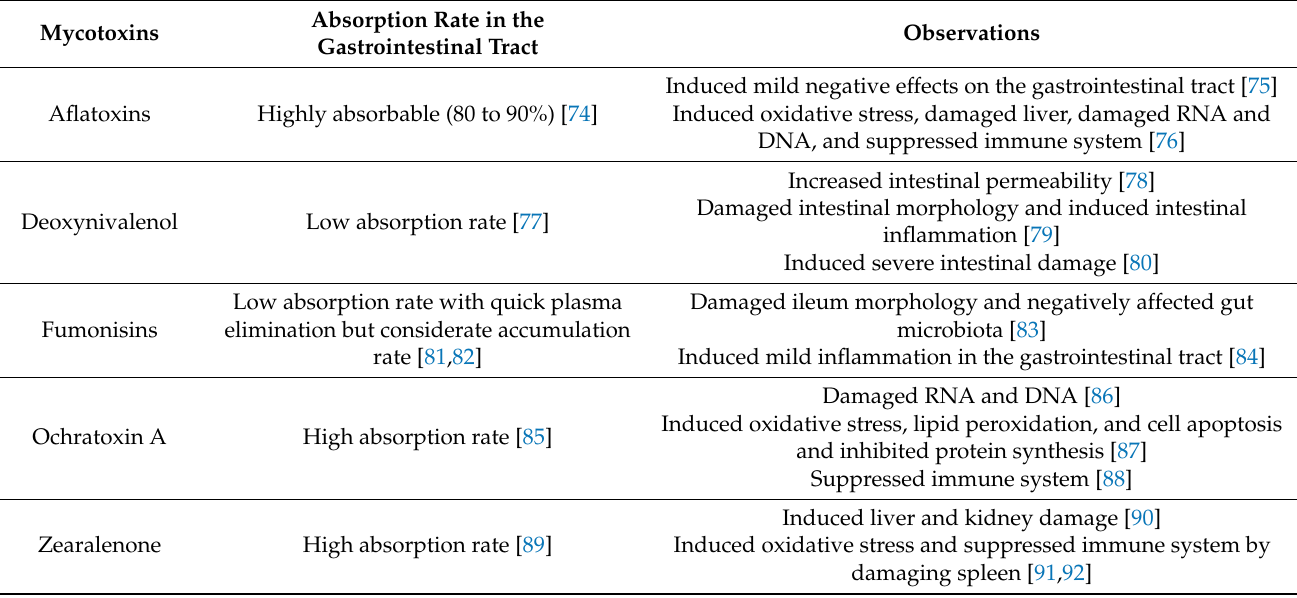
Table 4. Diverse kinds of mycotoxins, their absorption rates, and their effects on broiler